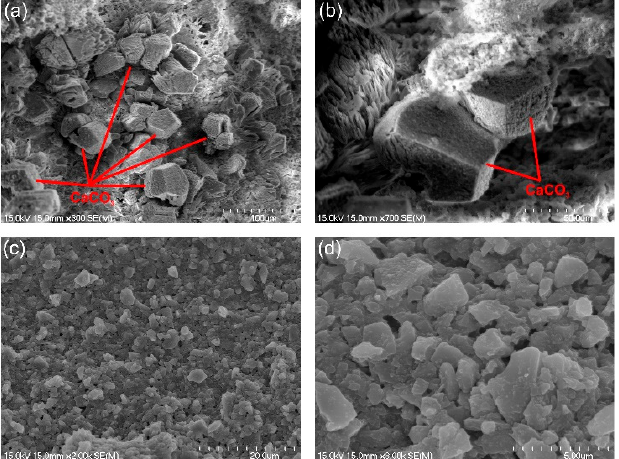
Figure 5. Scanning electron micrographs of dental composite: ( a , b ) supplemented with urease enzyme (self-healing composite) and ( c , d ) without urease enzyme (control).